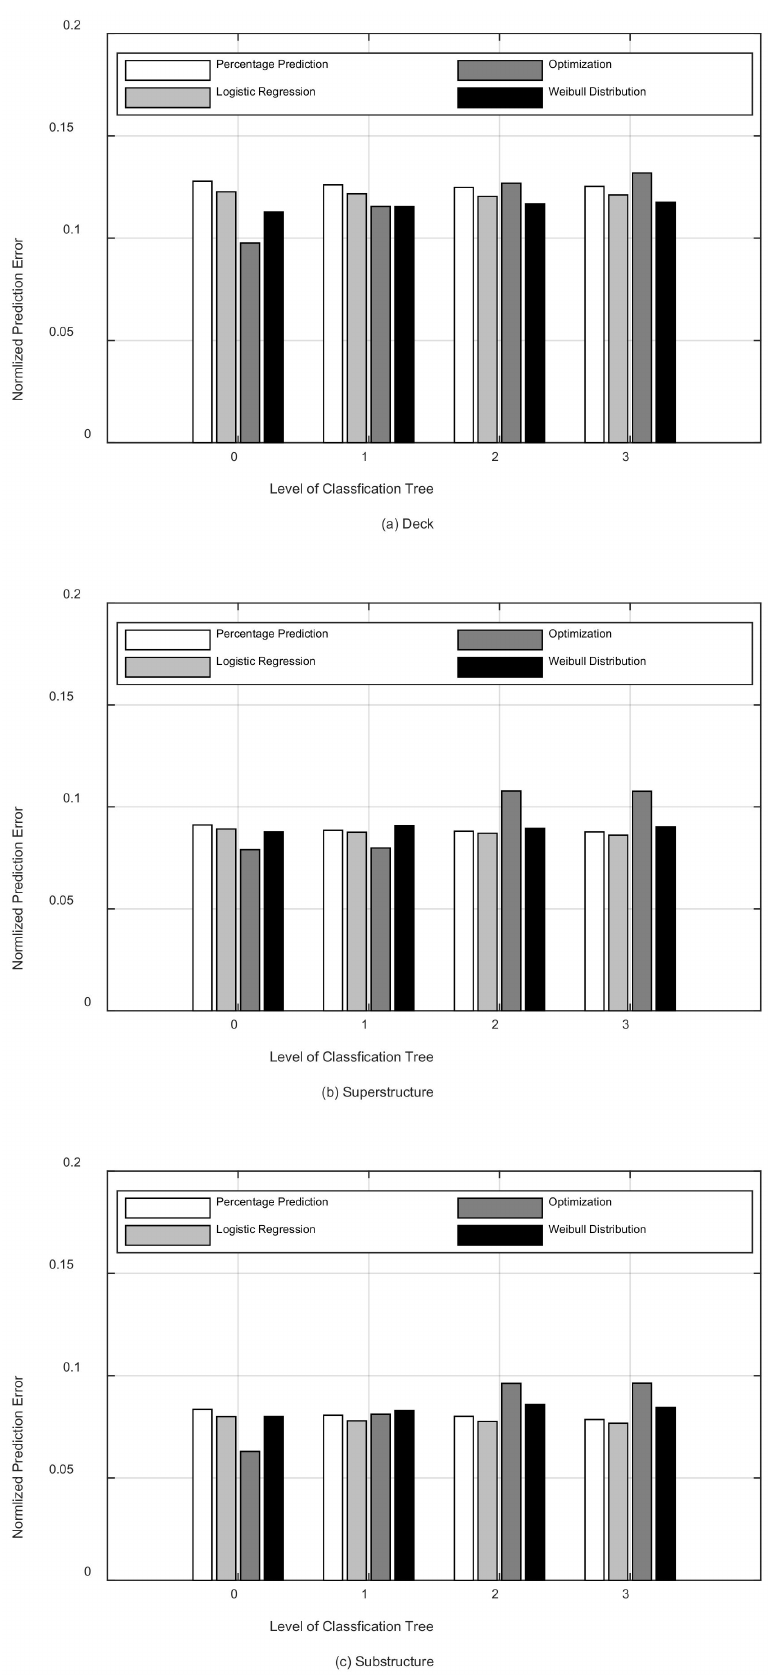
Figure 12. Normalized prediction error comparison of stochastic methods depending on the level of classification tree for ( a ) deck, ( b ) superstructure, and ( c )